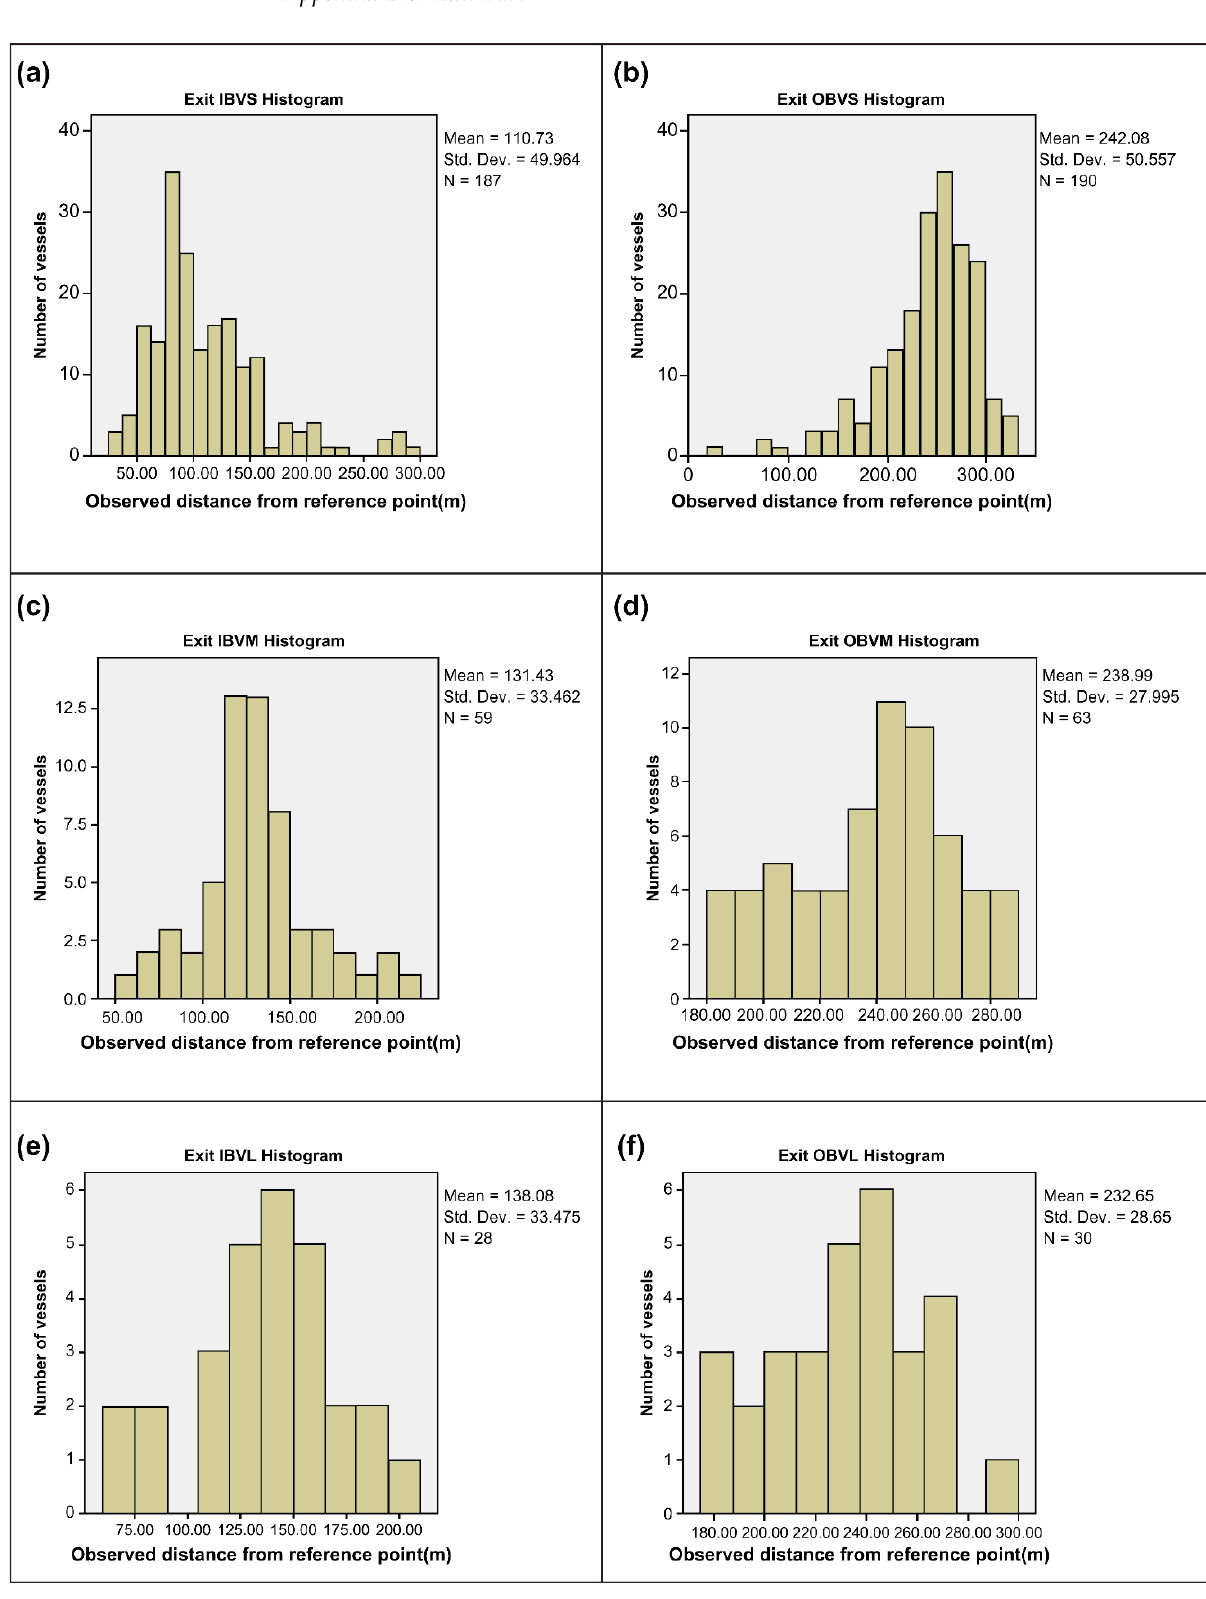
Figure A6. Histogram of the exit part: ( a ) small IBVs, ( b ) small OBVs, ( c ) mid-sized IBVs, ( d ) mid-sized OBVs, ( e ) large IBVs, and ( f ) large OBVs.